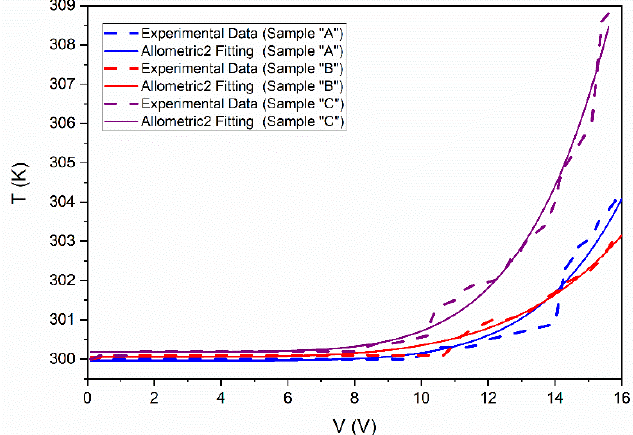
Figure 6. Temperature variation versus applied voltage for CNP-based electro-thermal components with graphite electrodes.